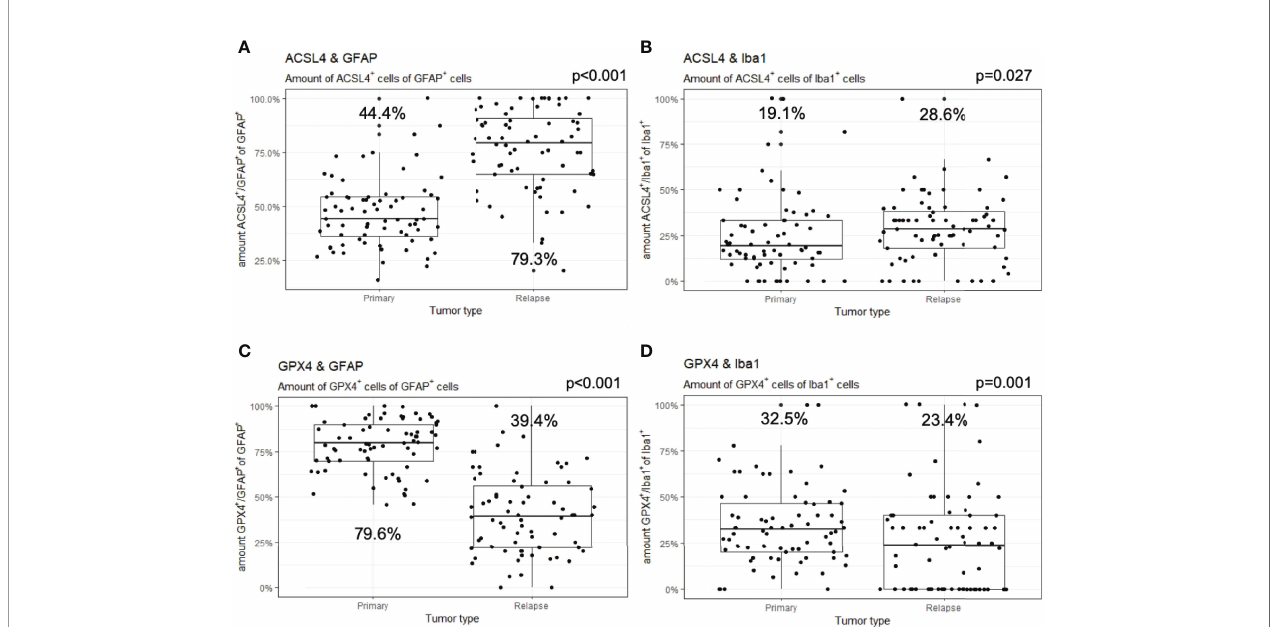
FIGURE 4 | Co-expression of ferroptosis-associated markers with GFAP and Iba1. Given are the numbers of ACSL4 + or GPX4 + cells of GFAP + or Iba1 + cells. The dots indicate the amounts of each patient in the primary and relapse tumor. (A) The number of ACSL4 + /GFAP + cells increases signi fi cantly in the relapse. (B) The amount of ACSL4 + /Iba1 + cells increases signi fi cantly in the relapse. (C) The number of GPX4 + /GFAP + cells decreases signi fi cantly in the relapse. (D) The amount of GPX4 + /Iba1 + cells decreases signi fi cantly in the relapse.